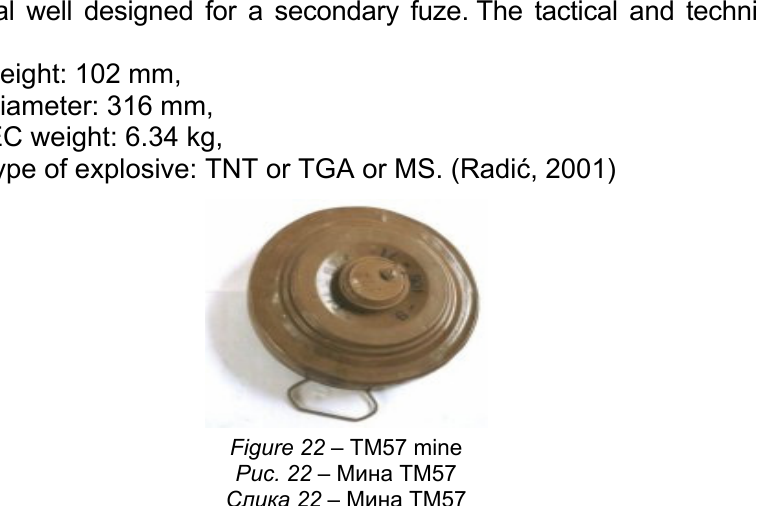
Figure 22 – TM57 mine Рис . 22 – Мина TM57 Слика 22 – Мина